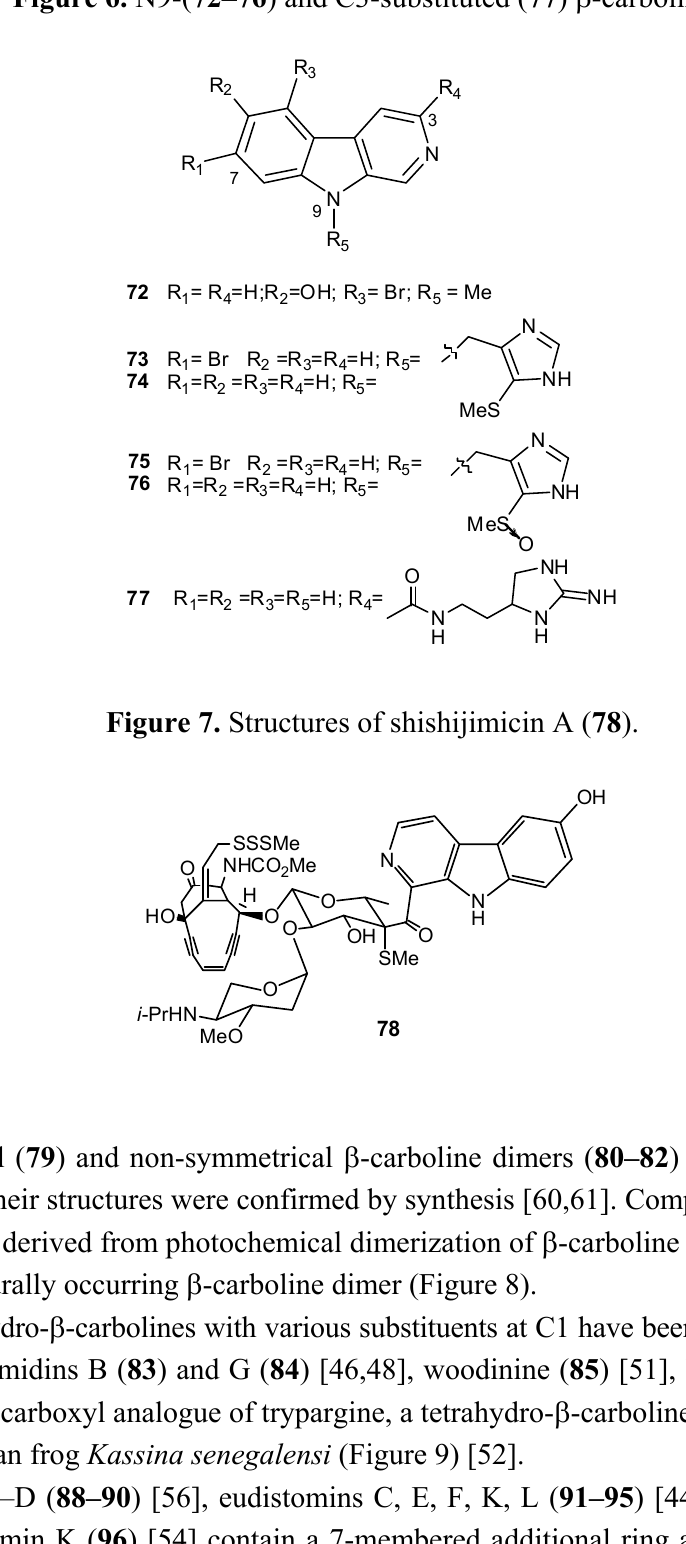
Figure 6. N9-( 72–76 ) and C3-substituted ( 77 )  -carbolines.